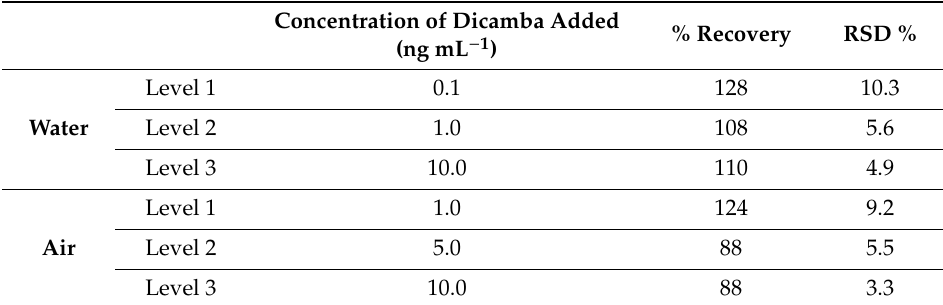
Table 2. Method recovery in air and water samples. RSD, relative standard